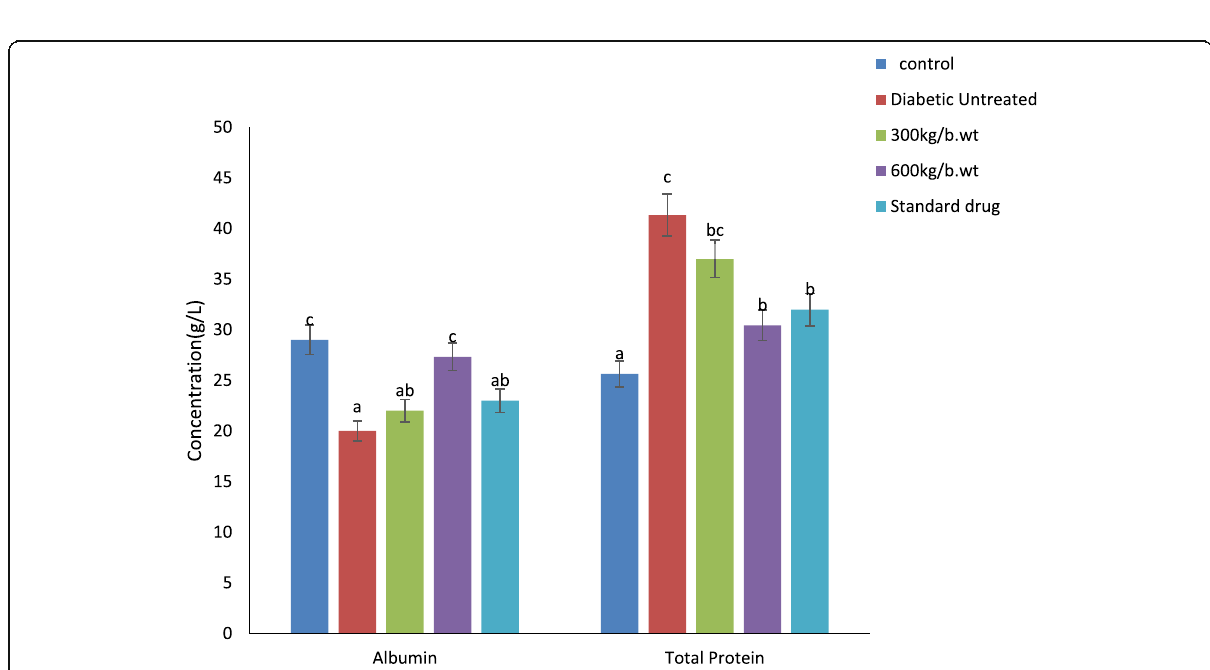
Fig. 3 Effect of Methanol Root Extract of Chromolaena odorata on Serum Albumin and Total Proteins in Alloxan Induced Diabetic Rats. Each bars represents Mean ± SEM of triplicate determinations. Bars with different alphabets indicate significant difference at ( p <